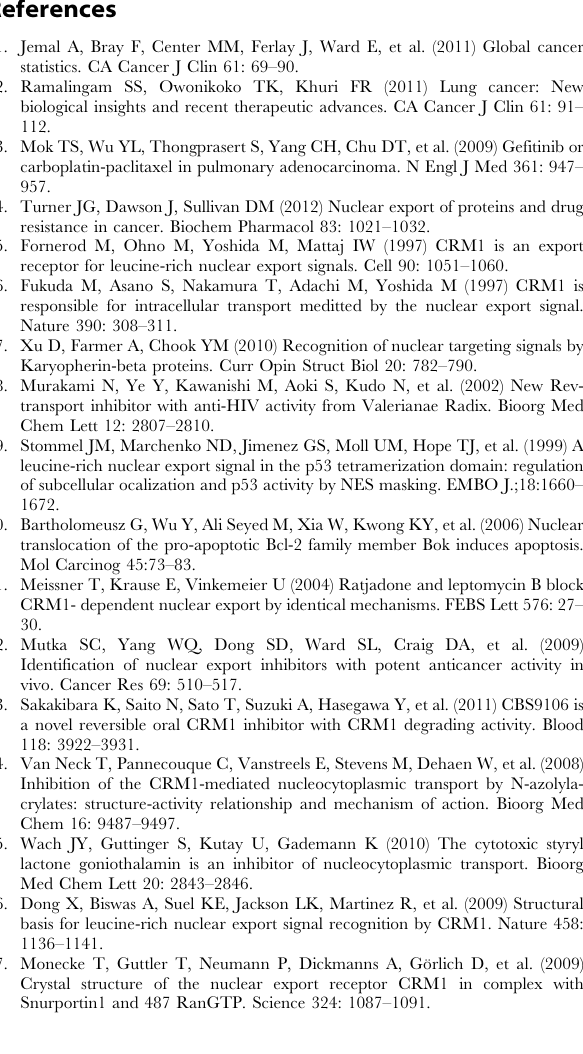
Figure S1 The localization and expression of EGFR, I k B- a , and NF- k B were detected in the presence and absence of KPT-185 by immunofluorescence microsco- py. The expression of EGFR was downregulated, and I k B- a and NF- k B was accumulated in nucleus in KPT-185 treatment group when compared to the control group (400 6 ). Figure S2 The protein levels of EGFR and survivin were detected in xenograft tumors by immunohistochemis- try. The expression of EGFR and survivin was downregulated in KPT-276 treatment group when compared to the control and gefitinib treatment group (400 6 ).